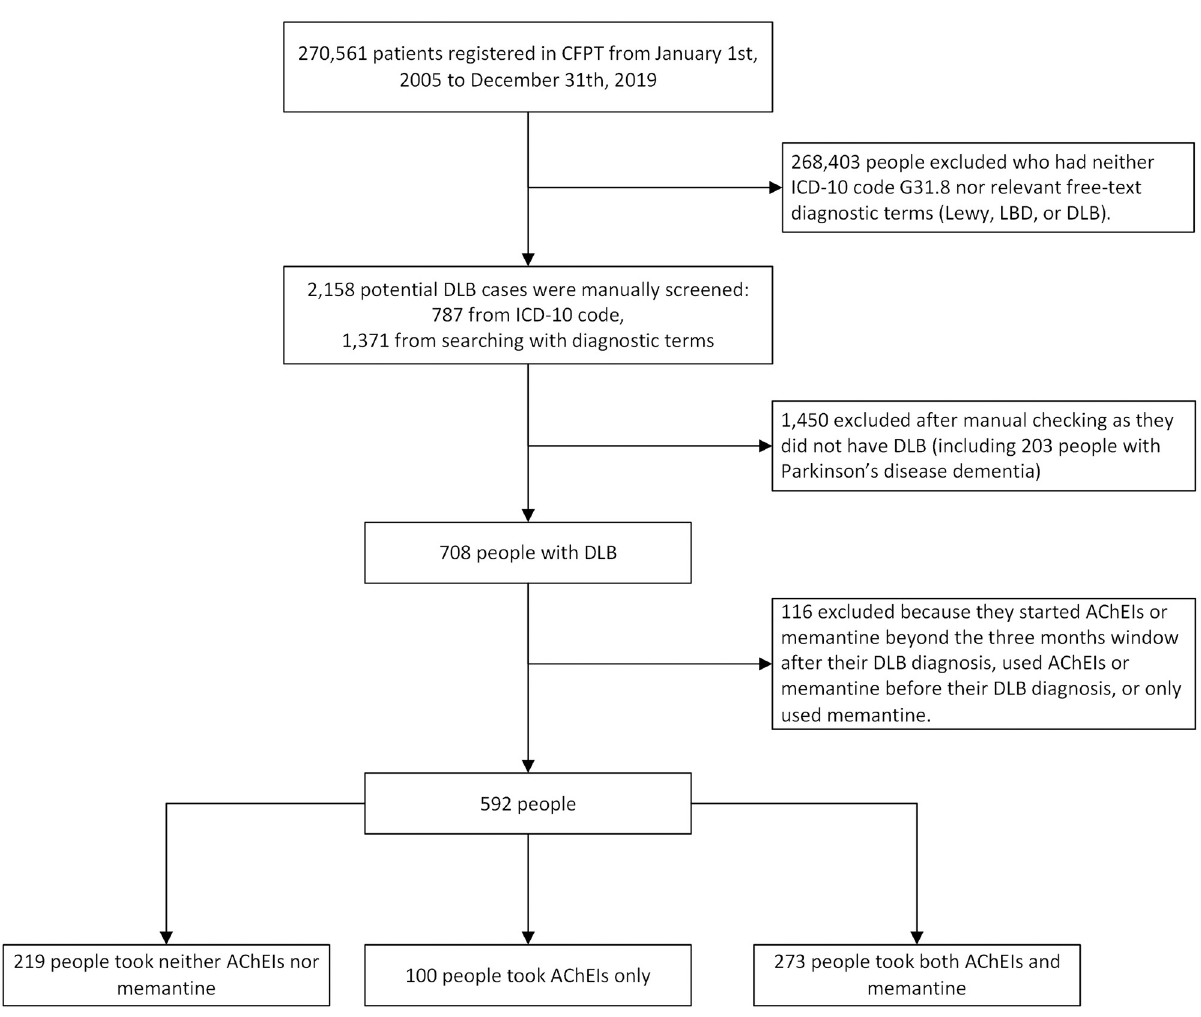
Fig 1. STROBE diagram showing construction of the cohorts. DLB, dementia with Lewy bodies; AChEIs, acetylcholinesterase inhibitors; LBD, Lewy body disease; DLB, dementia with Lewy body; CPFT, Cambridgeshire and Peterborough NHS Foundation Trust; ICD-10, World Health Organization International Statistical Classification of Diseases and Related Health Problems, 10th